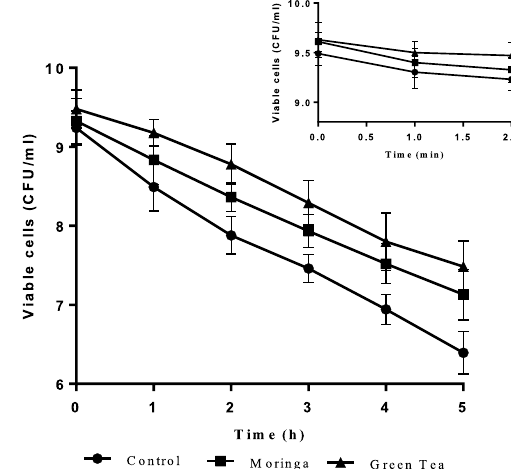
Fig. 2. Survival of control encapsulatedprobioticcells (CC) and novel encapsulatedprobioticcells (NC) with herbalextracts P. acidilactici DSM 20238upon sequential exposure to simulated salivary fluid (SSF) for 2 min, simulatedgastric fluid (SGF) for 2 h and simulated intestinal fluid (SIF) for 3 h. The insetrepresents the survival of cells when exposed in SSF for 2